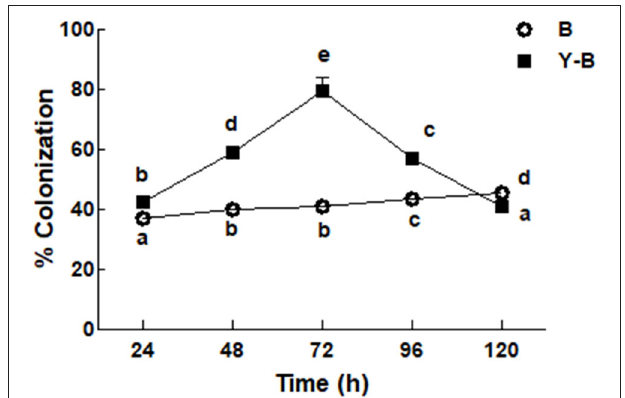
FIGURE 2 | Determination of fungal colonization on maize root under the stress of B (Bipolaris spp.), Y–B (yucasin –Bipolaris spp.). Data are mean from three independent experiments with standard error bars. Bars labeled with different letters are significantly different (Duncan test; p <